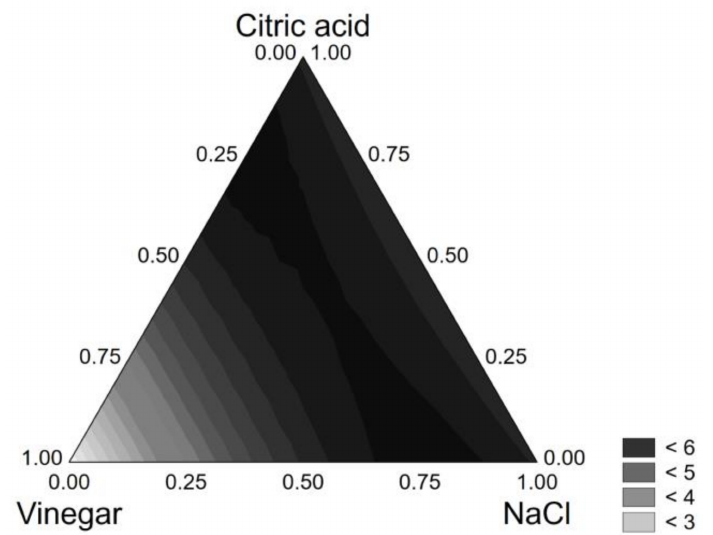
Figure 3. Ternary plot for the viability loss of L. plantarum 11 after 24 h in the model system.